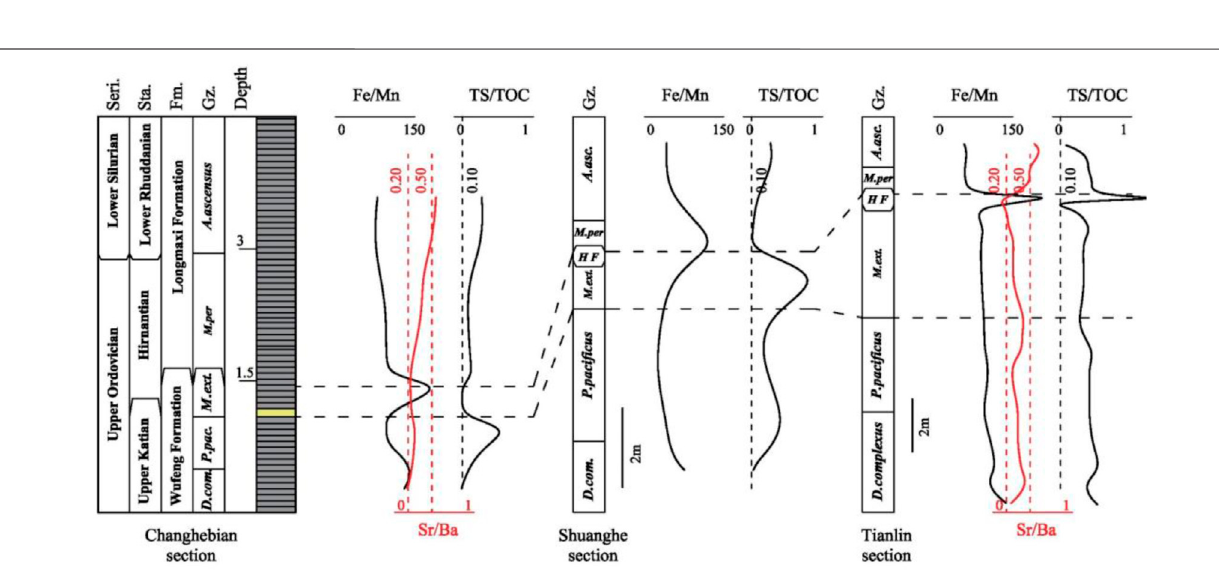
Frontiers in Earth Science |